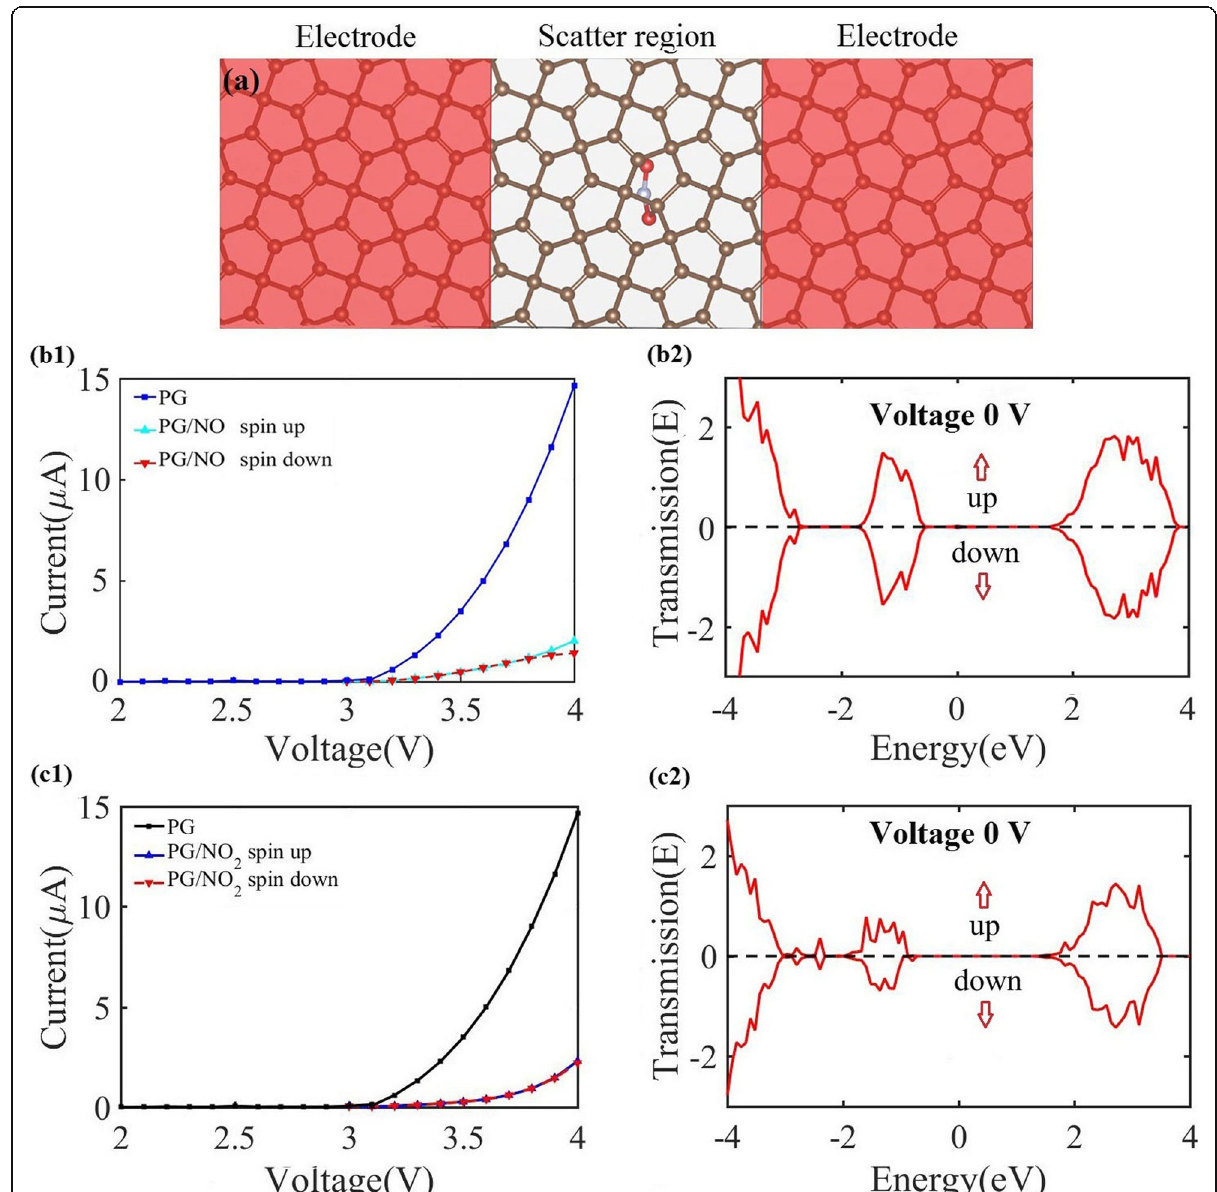
Fig. 4 Illustration of the two-probe systems ( a ) where semi-infinite left and right electrode regions (red shaded region) are in contact with the central scattering region. For the electrodes and scatter regions, 3 × 3 supercells without and with NO are used, respectively. In b1 and c1 , we display the I − V curves of pure PG and PG with the NO and NO 2 adsorption. The transmission spectra under zero bias are shown in c1 and